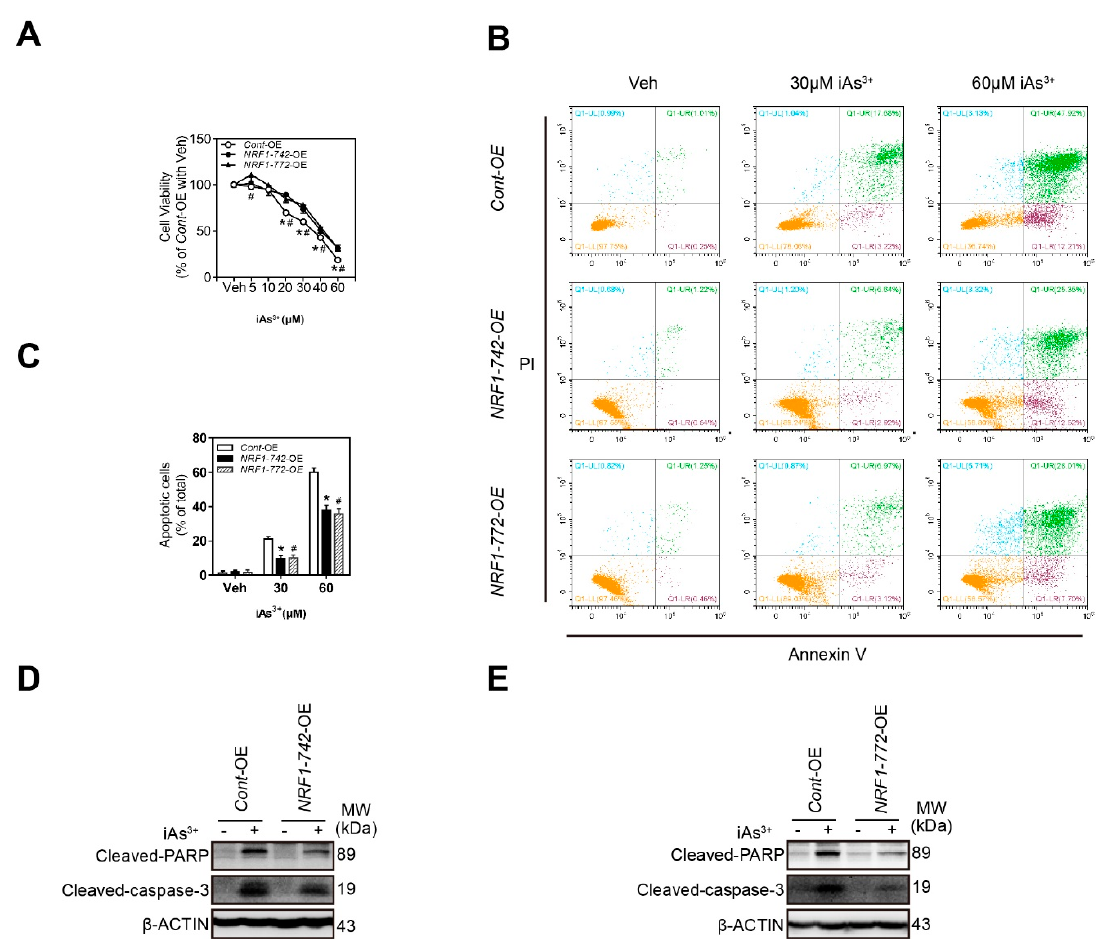
Figure 3. NRF1-742 -OE and NRF1-772 -OE HaCaT cells are resistant to the iAs 3 + -induced cytotoxicity. ( A ) Cell viability was assessed by the MTS assay 24 h of post- iAs 3 + exposure ( n = 6). The data are presented as the mean ± SD; * p < 0.05, NRF1-742 -OE versus Cont -OE HaCaT cells; # p < 0.05, NRF1-772 -OE cells versus Cont -OE HaCaT cells. ( B ) Representative flow cytometry images of Annexin V and PI staining. ( C ) Quantitative analysis of apoptosis. Cells were treated with the indicated concentrations of iAs 3 + for 18 h. The data are presented as the mean ± SD; * p < 0.05, NRF1-742 -OE versus Cont -OE HaCaT cells; # p < 0.05, NRF1-772 -OE cells versus Cont -OE HaCaT cells. ( D , E ) Cleaved PARP and caspase-3 immunoblotting of whole cell lysates from HaCaT cells treated with 30 µ M iAs 3 + for 6 h. β -actin served as the loading control.